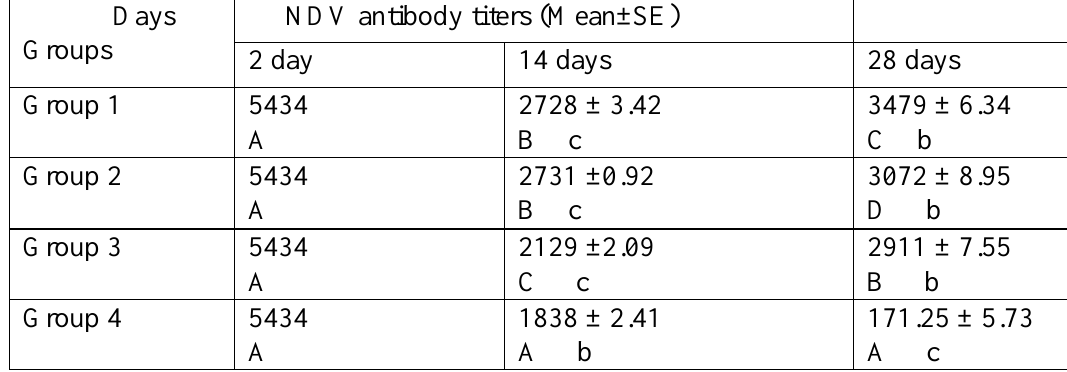
Table-4: Effect of supplementation β-glucan ( 225 µg/ml ) on antibody titer for NDV vaccine for each group